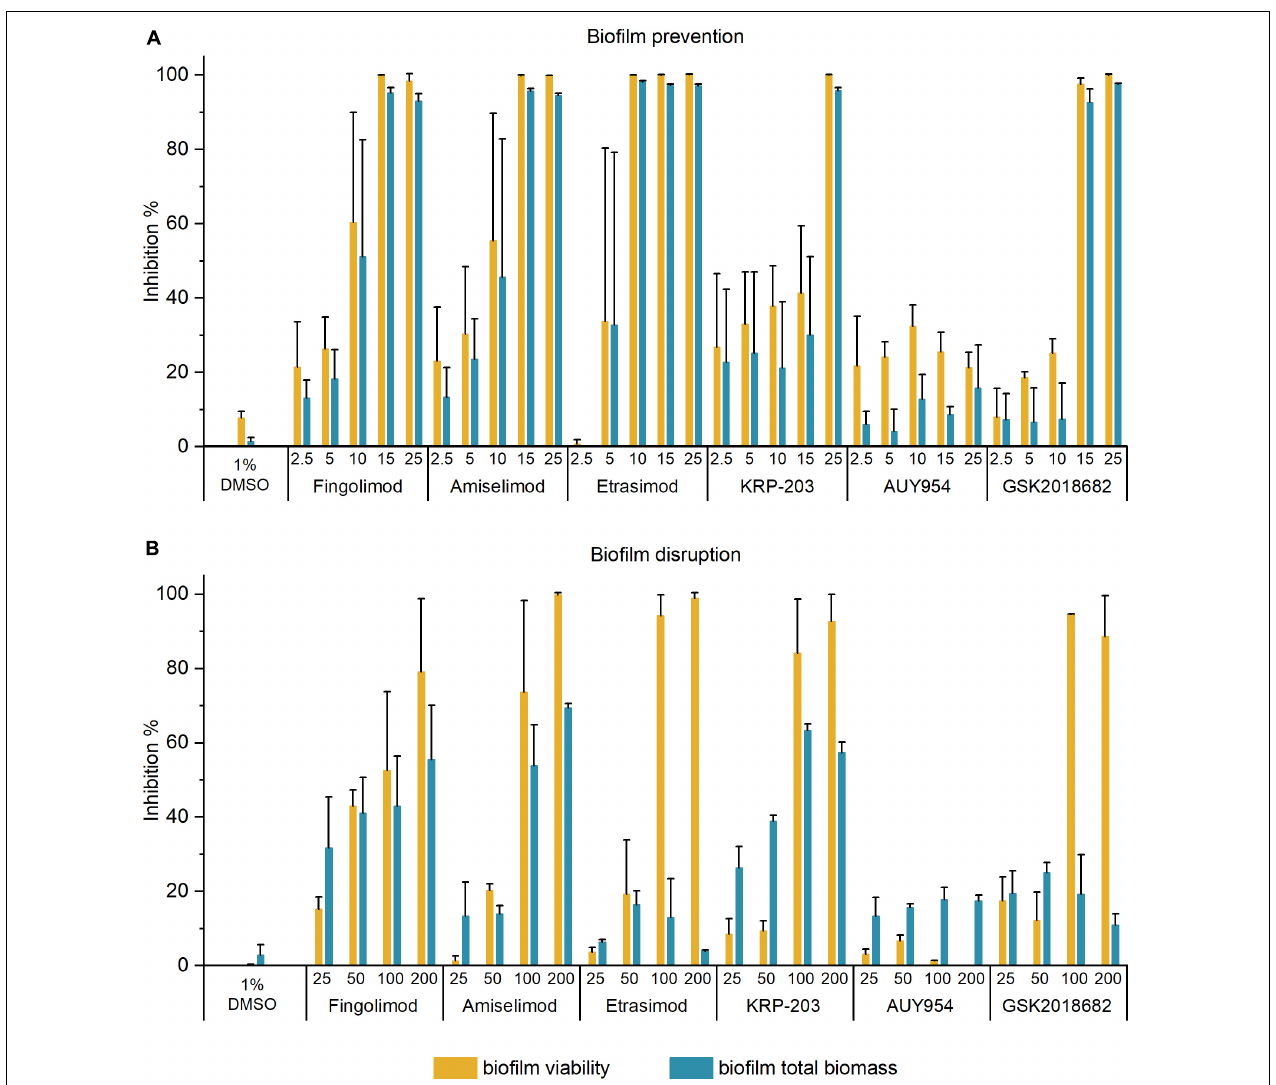
FIGURE 1 | Inhibition of biofilm viability and biofilm biomass of Staphylococcus aureus biofilms in panel (A) pre-exposure; and (B) post-exposure assay by different concentrations of active S1PR modulators. The results are expressed as the average inhibition percentage ± SD of two or three biological repetitions, each with two or three technical